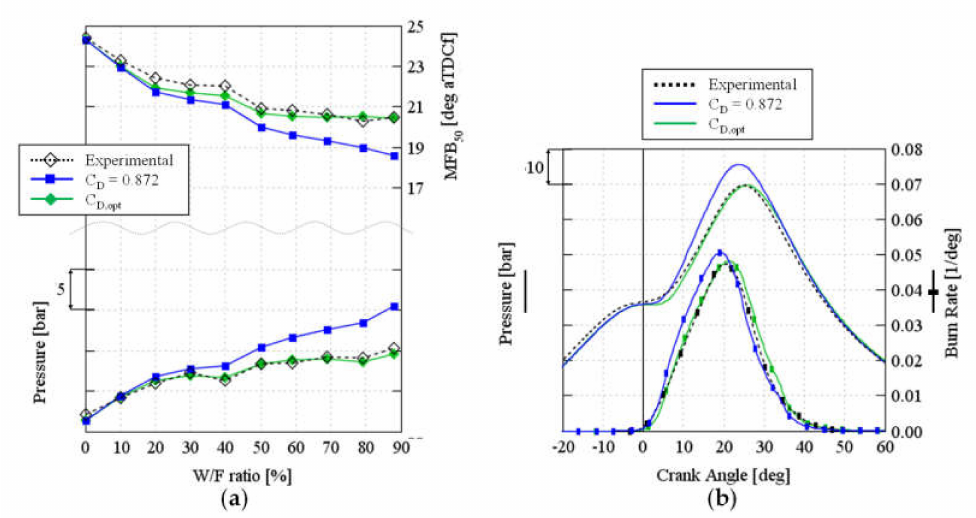
Figure 11. ( a ) Crank Angle corresponding to 50% of fuel burned (top), and maximum in-cylinder pressure (bottom) as a function of the Water-to-Fuel ratio; ( b ) Pressure Cycle (left), and Burn Rate (right) for a Water-to-Fuel ratio of 90%; operating point 2500 rpm–18 bar; simulated (solid lines) and experimental (black dashed